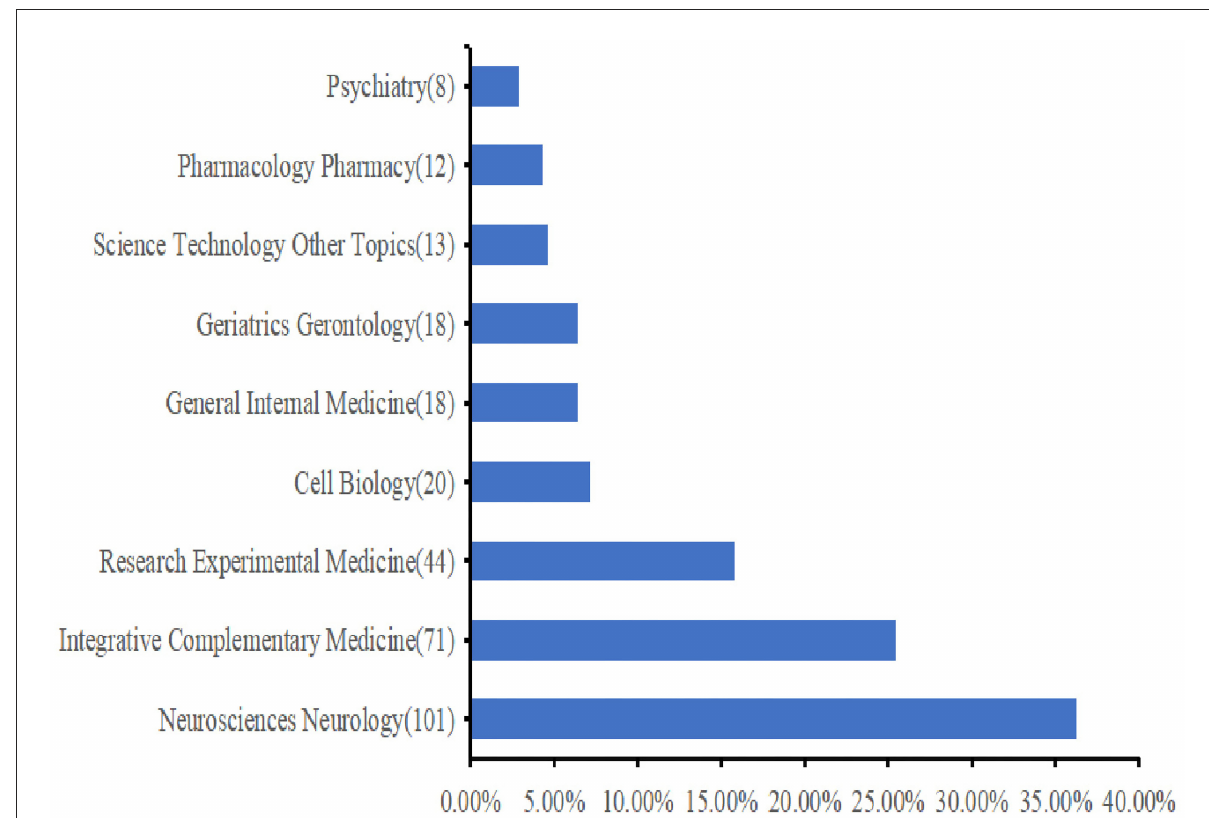
FIGURE3 The top 10 research areas about acupuncture therapy for cognitive impairment (CI). The bar chart is used to describe the top 10 research areas. Each specific research area is listed on the Y -axis, and the corresponding percentage on the X -axis has its